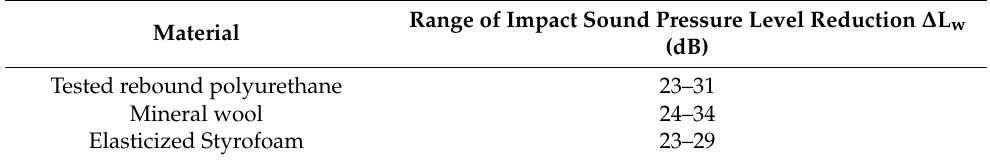
Table 7. Comparison of impact sound pressure level reduction of rebound polyurethane with other materials. It is assumed that the floating slab is screed made of sand/cement or calcium sulfate with a surface density of 80 kg/m 2 (according to the producers’